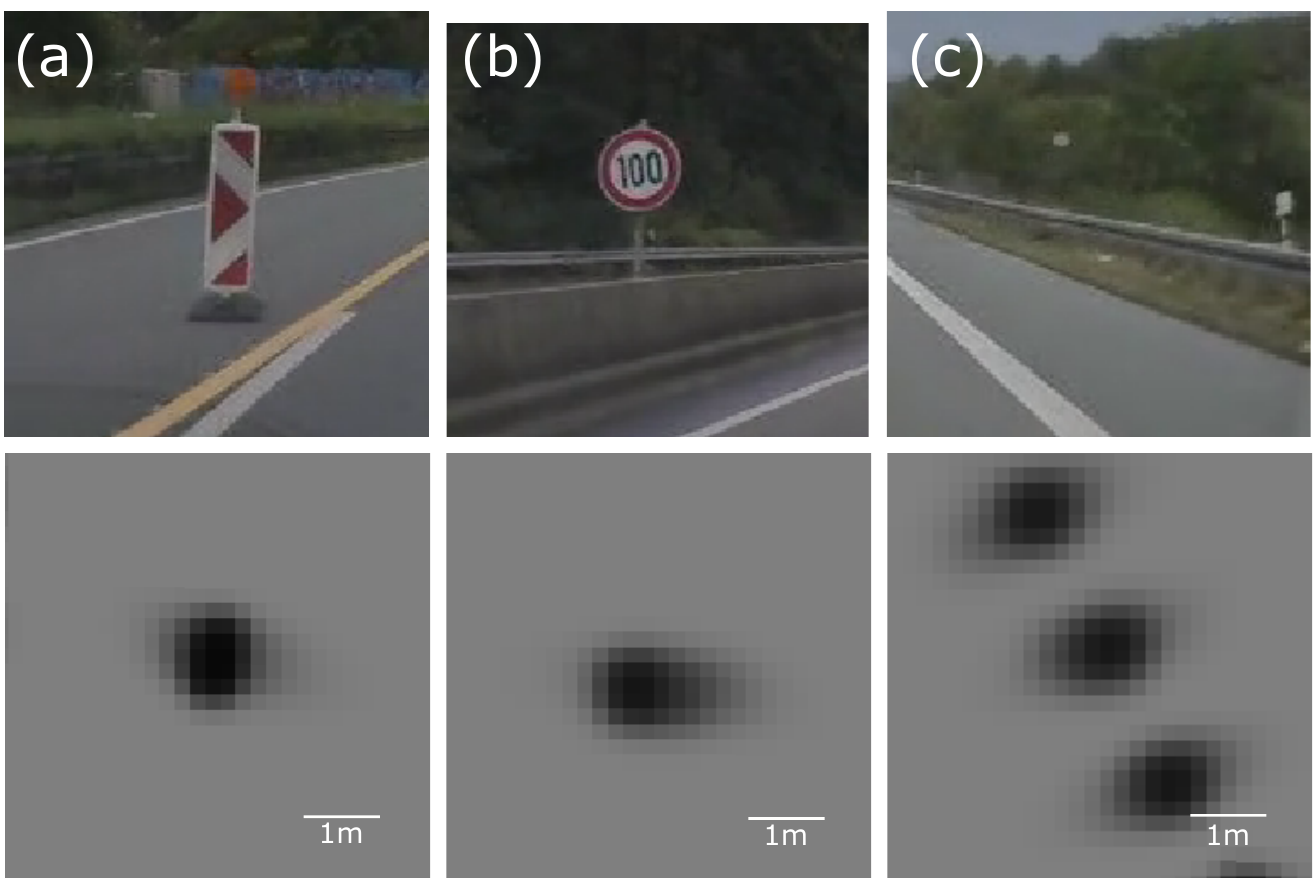
Figure 4. Examples of the occupancy grid representations of highway pole-like objects with corresponding video frames: ( a ) traffic bollard; ( b ) sign; ( c ) guardrail. The occupancy grid is generated using a single automotive-graded radar located in front of the